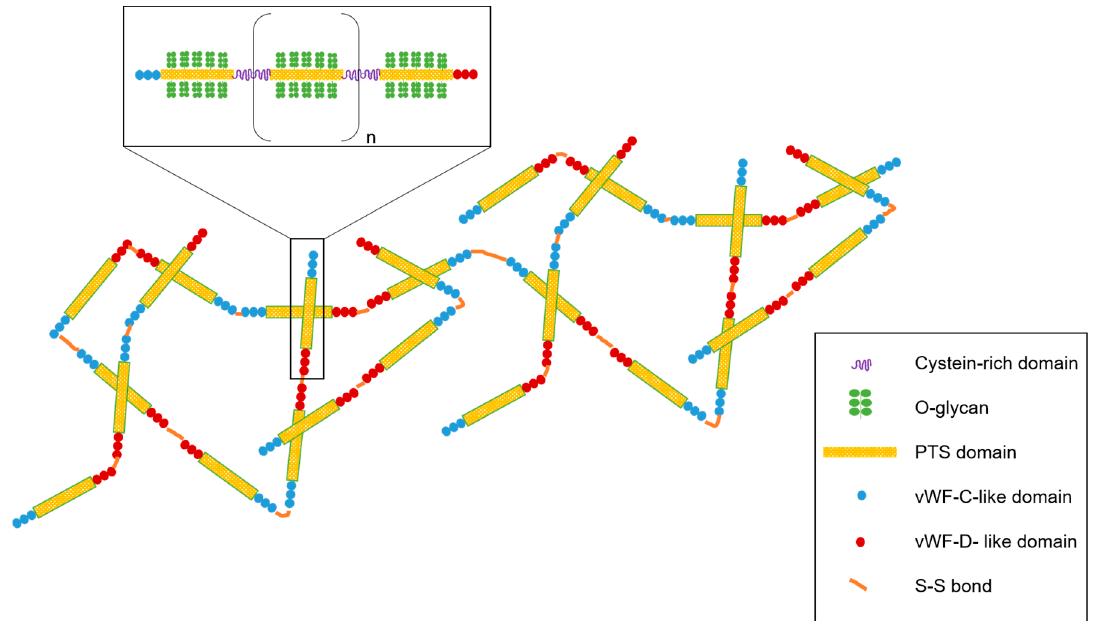
Figure 2. General structure of mucins, the main constituent of mucus. Mucin contains the PTS (proline, threonine, and serine) domain and supporting O-glycan. The PTS domain is interspaced with cysteine-rich domains. Mucin glycopolymer ends with the von Willebrand factor (vWF) domain in N- and C-terminal regions. Mucin polymerized via disulfide bonds and mucin polymers interact with each other via hydrophobic and electrostatic interactions.